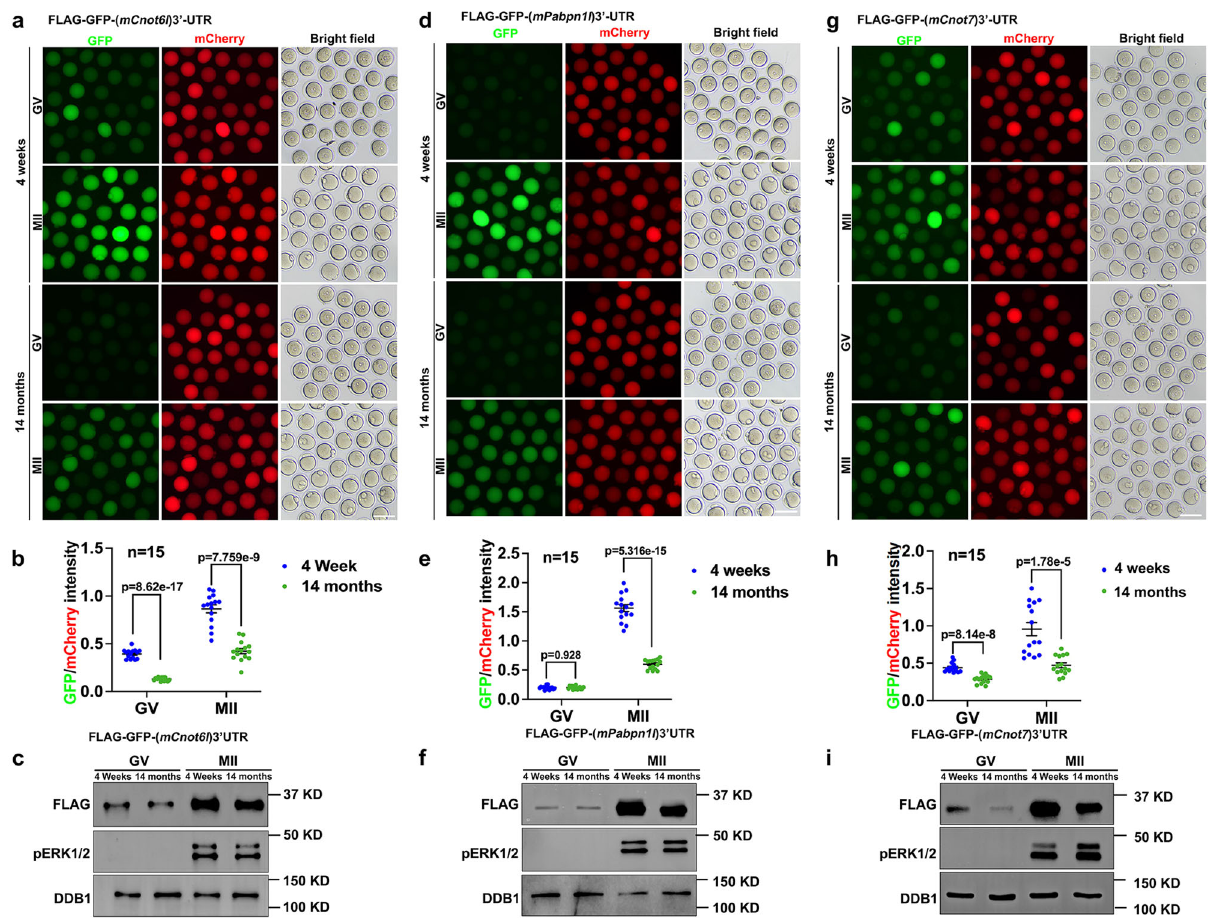
Fig. 8 Translational activities of transcripts encoding factors related to maternal mRNA clearance in oocytes of 4-week or 14-month-old WT mice. Fluorescence microscopy ( a ), quanti fi cation of the fl uorescent signals ( b ), and western blot ( c ) results showing the translation activities of the Cnot6l 3 ′ - UTR in GV-arrested or MII-arrested oocytes of 4-week or 14-month-old mice. The GFP signal indicated translational activation of the Btg4 3 ’ -UTR. An in vitro transcribed and polyadenylated mCherry mRNA was co-injected as a positive control. Fluorescence microscopy ( d ), quanti fi cation of the fl uorescent signals ( e ), and western blot ( f ) results showing the translation activities of the Pabpn1l 3 ′ -UTR in GV or MII oocytes of 4-week or 14-month-old mice. Fluorescence microscopy ( g ), quanti fi cation of the fl uorescent signals ( h ), and western blot ( i ) results showing the translation activities of the Cnot7 3 ′ -UTR in GV or MII oocytes of 4-week or 14-month-old mice. Scale bar = 100 µ m ( a, d, g ). In b, e and h , data are presented as mean values± SEM. P by two-tailed Student ’ s t -test. n = 15 oocytes for each experimental